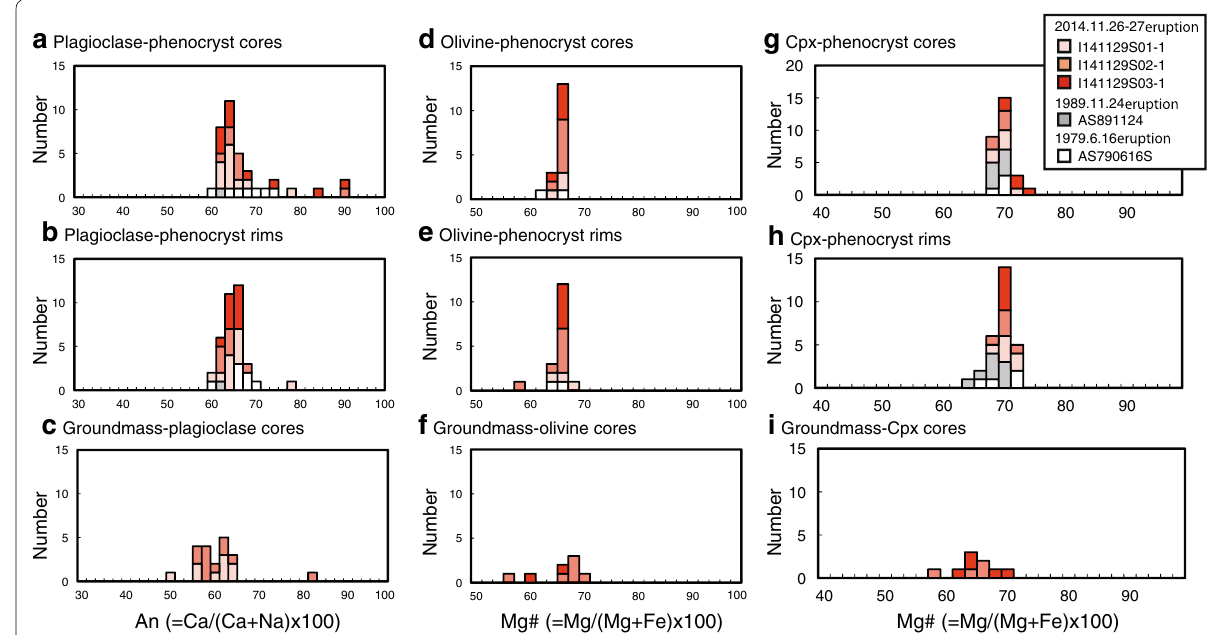
Fig. 3 Chemistry of phenocrysts and groundmass minerals in the 1979, 1989, and 2014 scoria. Repeated analyses of reference minerals of plagioclase, augite, and olivine indicated precision of An the olivine (Fo90.5) (Saito et al.